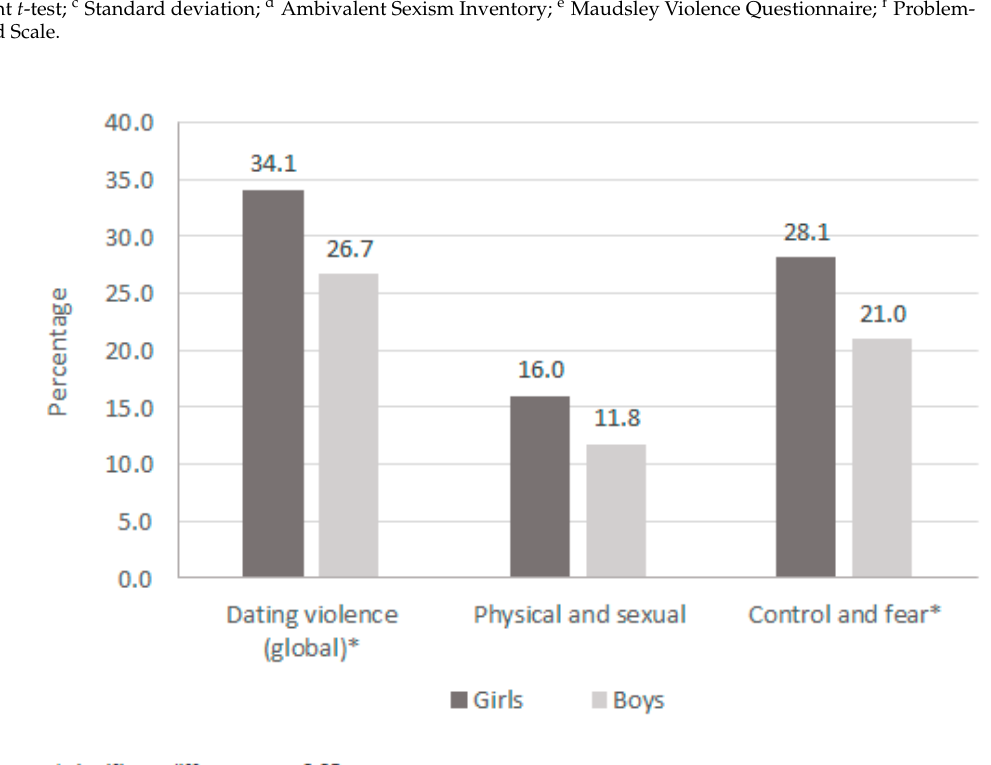
Solving Inventory-Revised Scale.